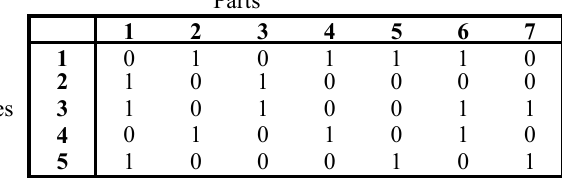
Fig. 4. Machine-part matrix for the numerical